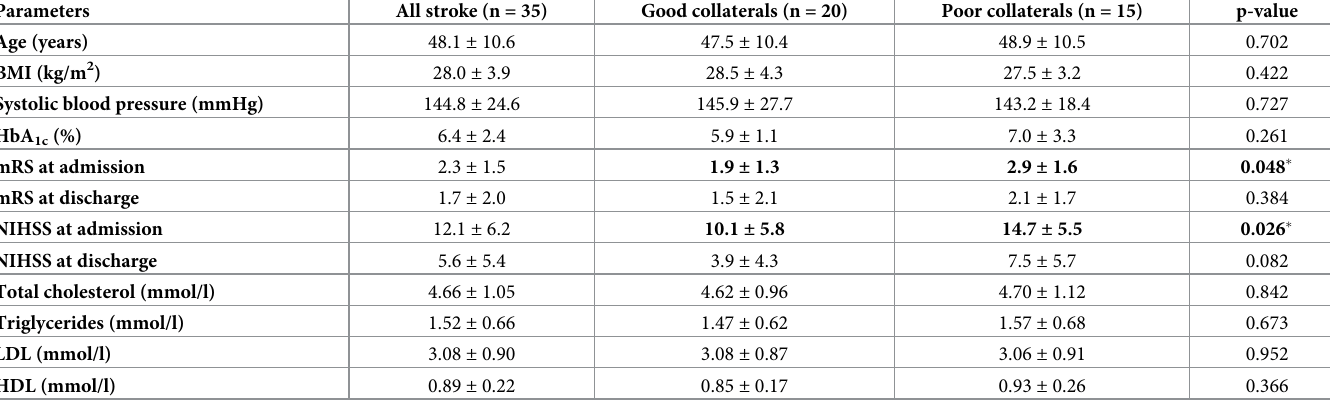
Table 1. Demographic, metabolic and clinical characteristics of the participants (n = 35) with acute ischemic stroke with good and poor pial collaterals expressed as mean ± SD.